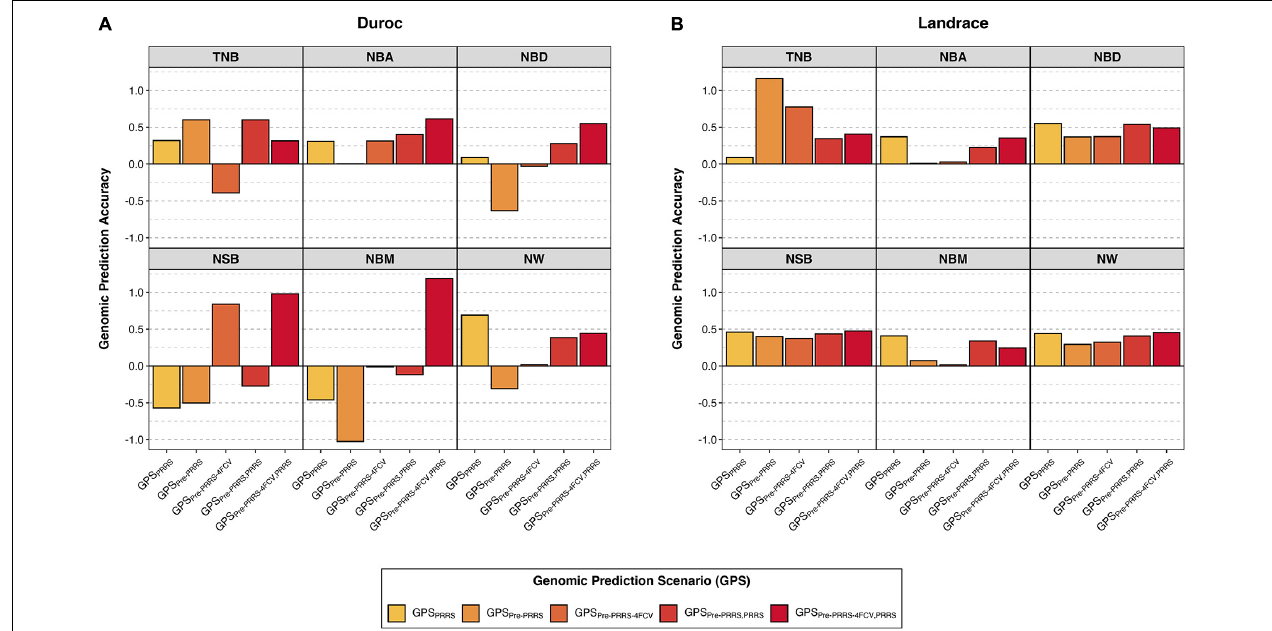
FIGURE 2 | Genomic prediction accuracies of reproductive traits during a Porcine Reproductive and Respiratory Syndrome (PRRS) outbreak. Results are presented for Duroc (A) and Landrace (B) across genomic prediction scenarios (GPS) for total number born (TNB), number born alive (NBA), number born dead (NBD), number of stillborn (NSB), number born mummified (NBM), and number of piglets weaned (NW) using BayesB. The y -axis represents the genomic prediction accuracy and the x -axis the GPS. Details for the different GPS are available in Table 2 . Results for all methods and standard deviations across folds are available in Supplementary Table 2